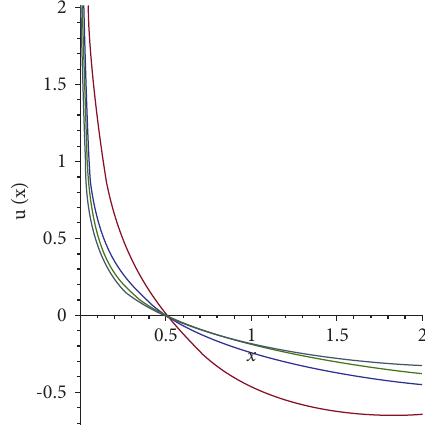
given in (20) for α � 1 . 5 , 2 , 3 , 4 and ] � 15. 3